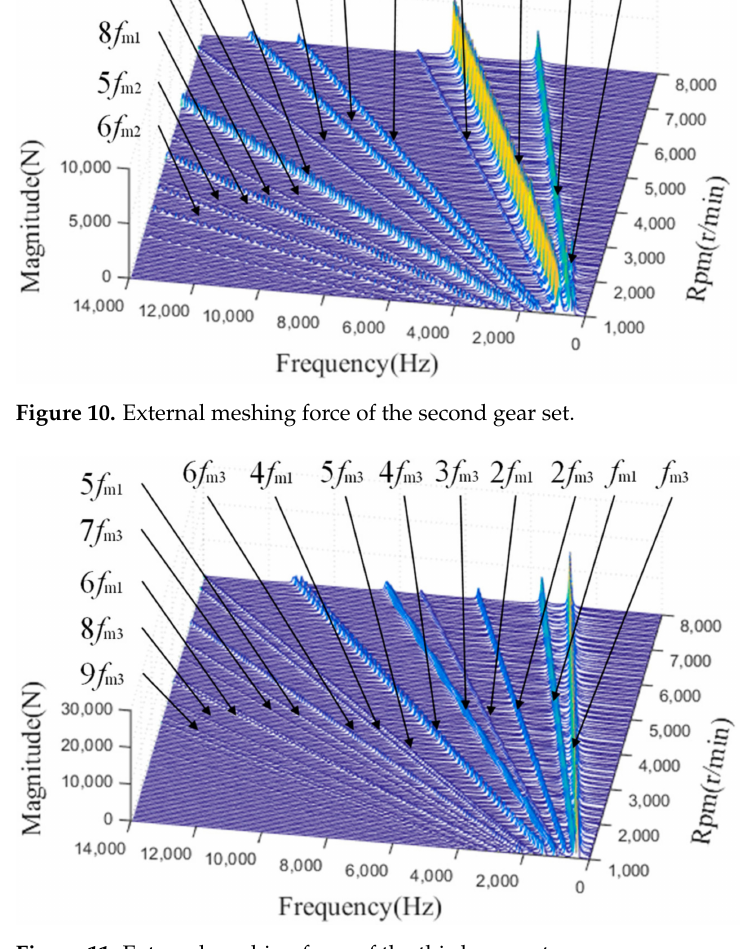
Figure 11. External meshing force of the third gear